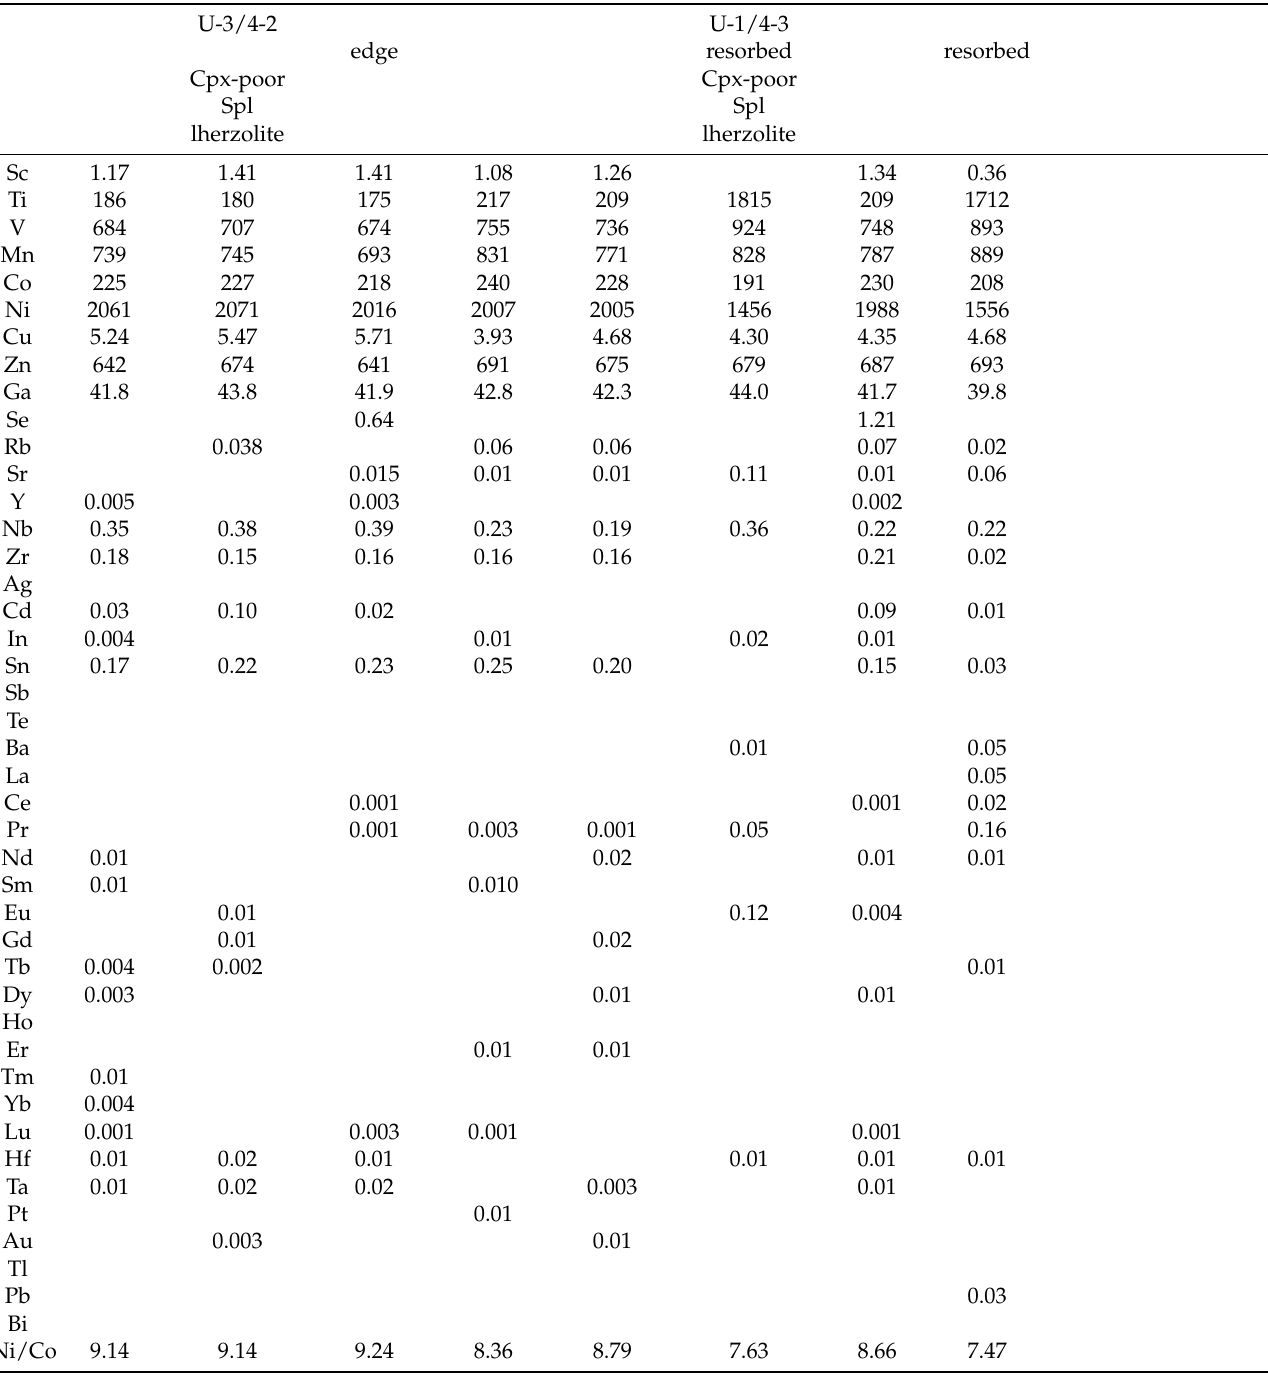
Table 3. Representative trace element compositions of spinel in lherzolite upper mantle xenoliths from Jetty Peninsula